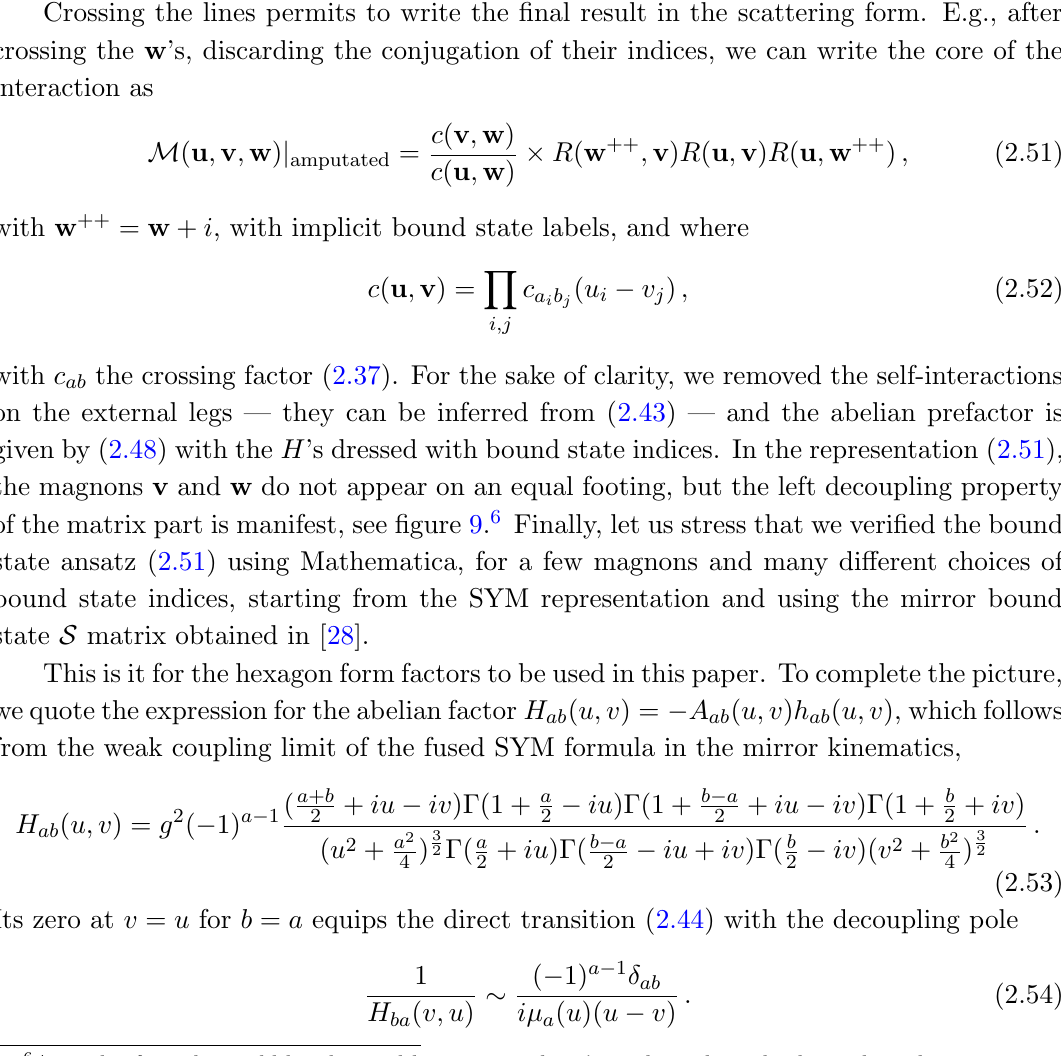
Figure 9 . Decoupling condition for the three-body matrix part. In the limit v interaction reduces to a permutation. After (cid:13)ipping the arrow on the w line, using the crossing property of the R matrix, the interactions between u and w are seen to collapse thanks to the unitarity of the R